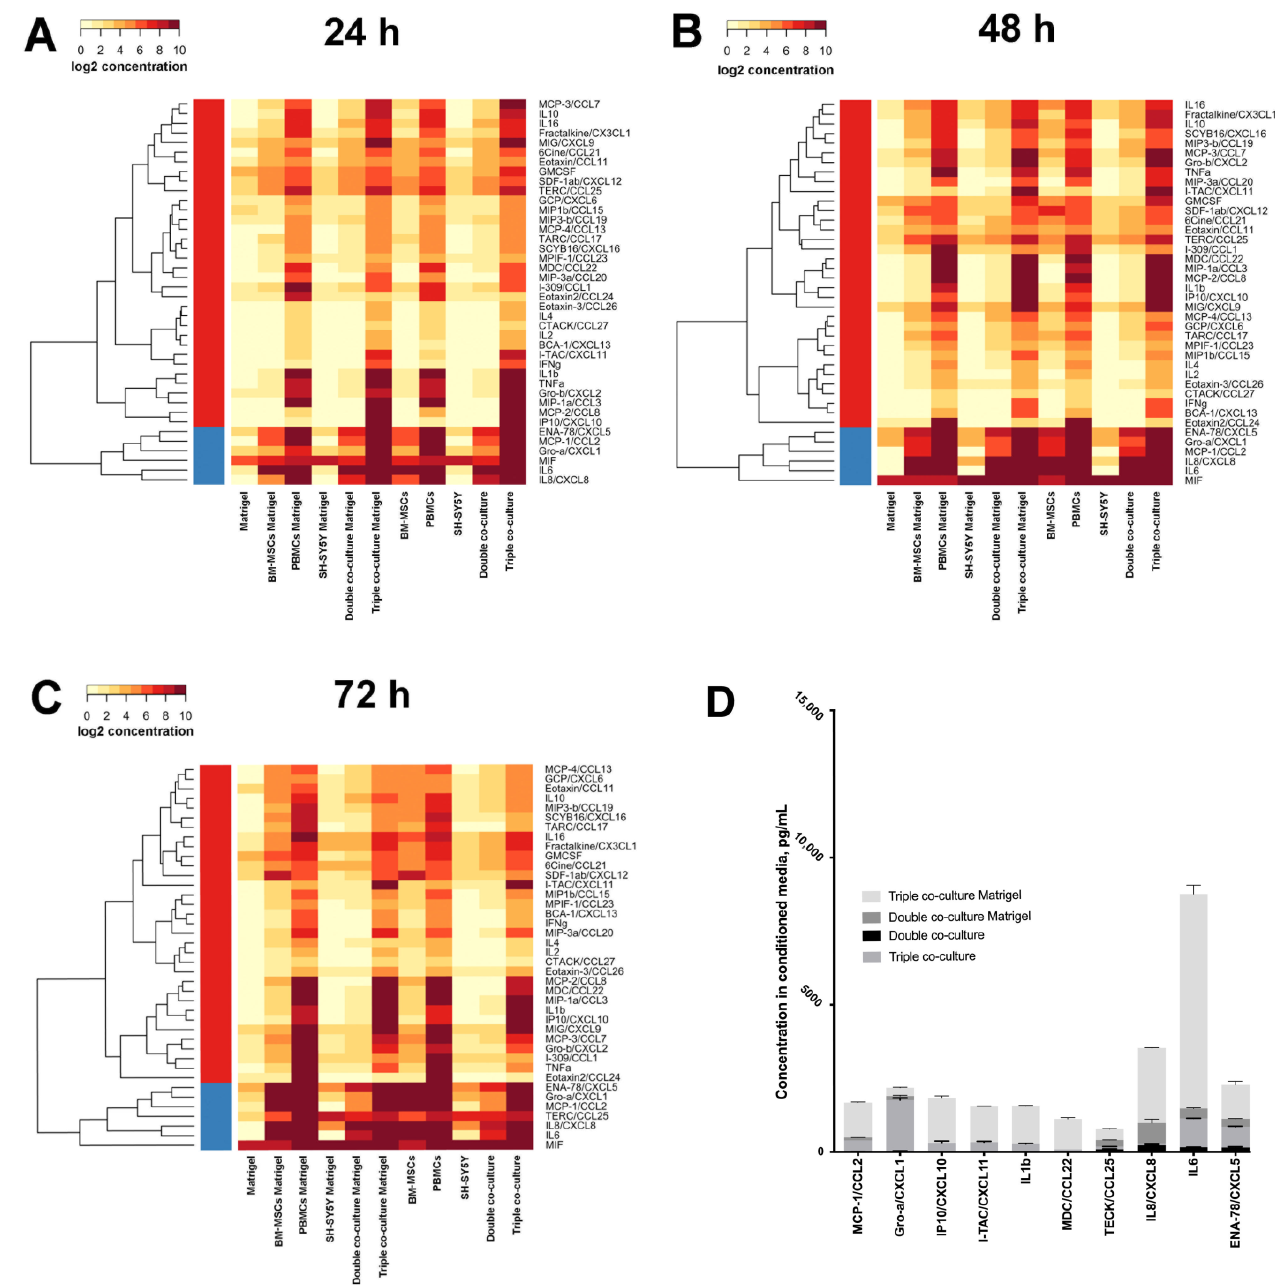
Figure 6. Heat map of cytokine concentrations after 24 ( A ), 48 ( B ), and 72 ( C ) hours of incubation. Data are presented as the logarithm (log 2 ) of the mean value in the experiment. The overall comparison of the cytokines with the highest concentration for double and triple co-cultures ( D ).